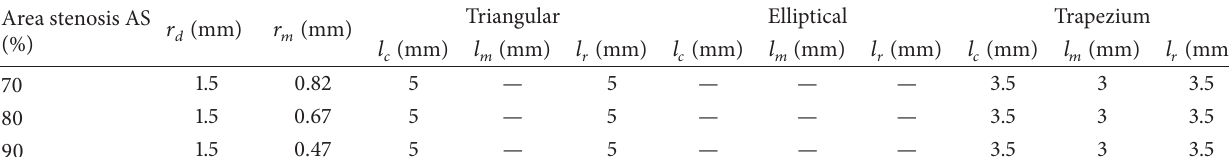
Table 1: Dimensions of geometric shapes of stenosis. All the dimensions are in mm.